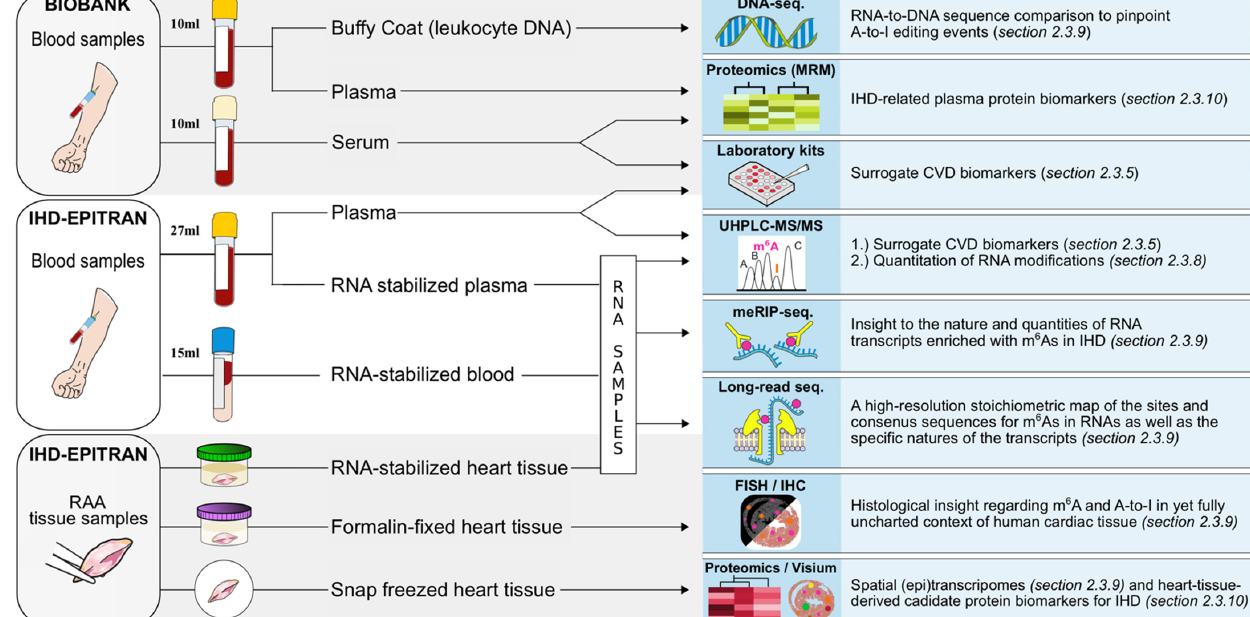
Figure 4. Study samples with respective principal analysis methods of the IHD-EPITRAN study. CVD , cardiovascular disease; FISH , fluorescence in situ hybridization; IHC , immunohistochemistry; IHD , ischemic heart disease; meRIP seq , methylated RNA immunoprecipitation sequencing; MRM , multiple reaction monitoring; RAA , right atrial appendage; UHPLC-MS/MS ; ultra-high-performance triple quadrupole liquid chromatography tandem mass